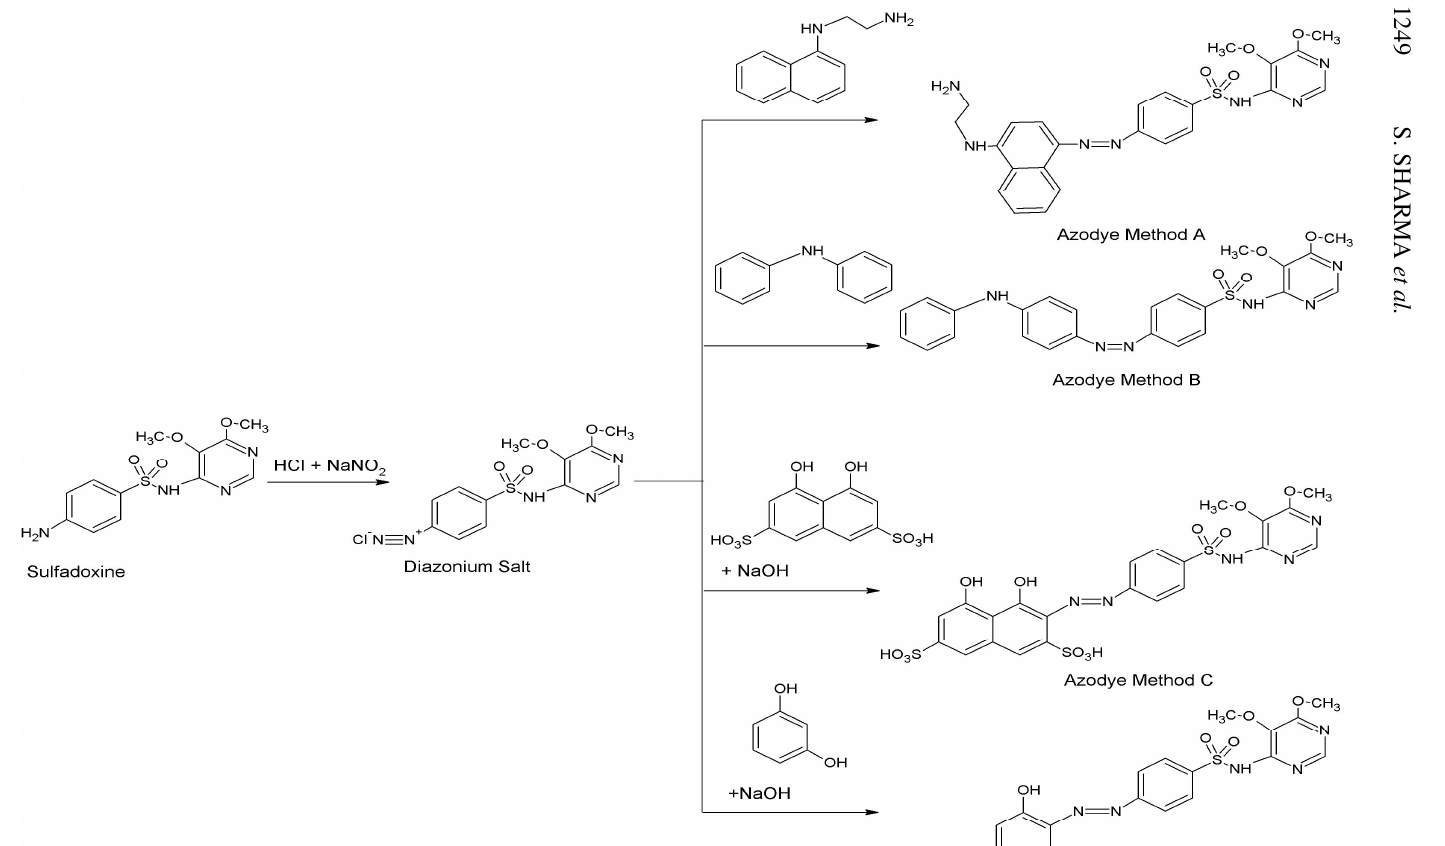
Figure 1. Proposed reaction scheme for method A, B, C and